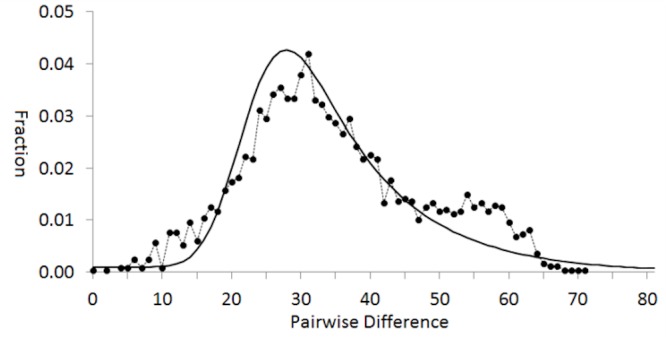
Population expansion as inferred from the pairwise mismatch distribution of Harp Seals (DnaSP: [54]).The null hypothesis of constant population size is rejected (Fu & Li’s [26] and Tajima’s [27] D statistics both p << 0.01) in favor of a population expansion with an estimated τ = 33.4 corresponding to the upward inflection of the peak, at 57 KYA by the calibration in Fig 4.